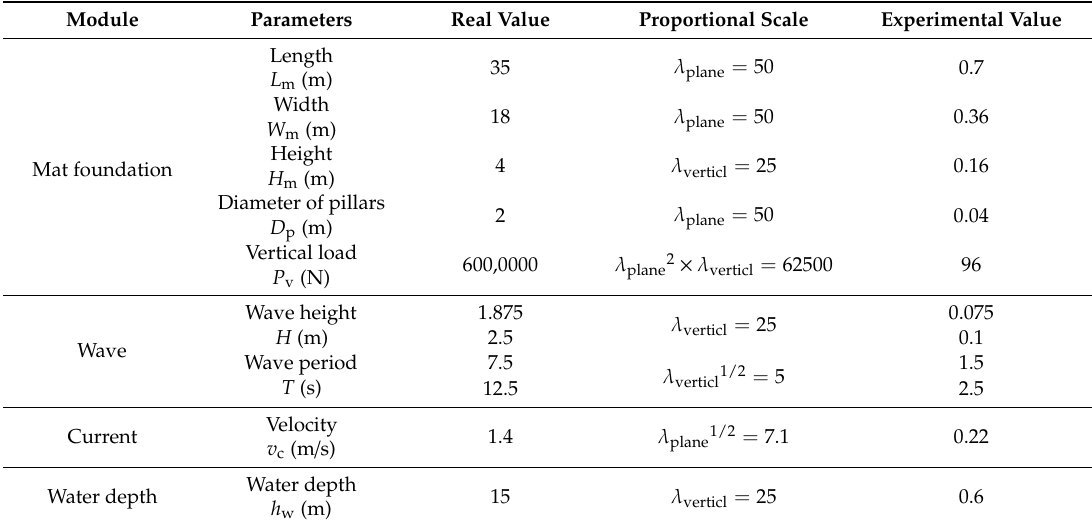
Table 2. The corresponding parameters of actual condition and